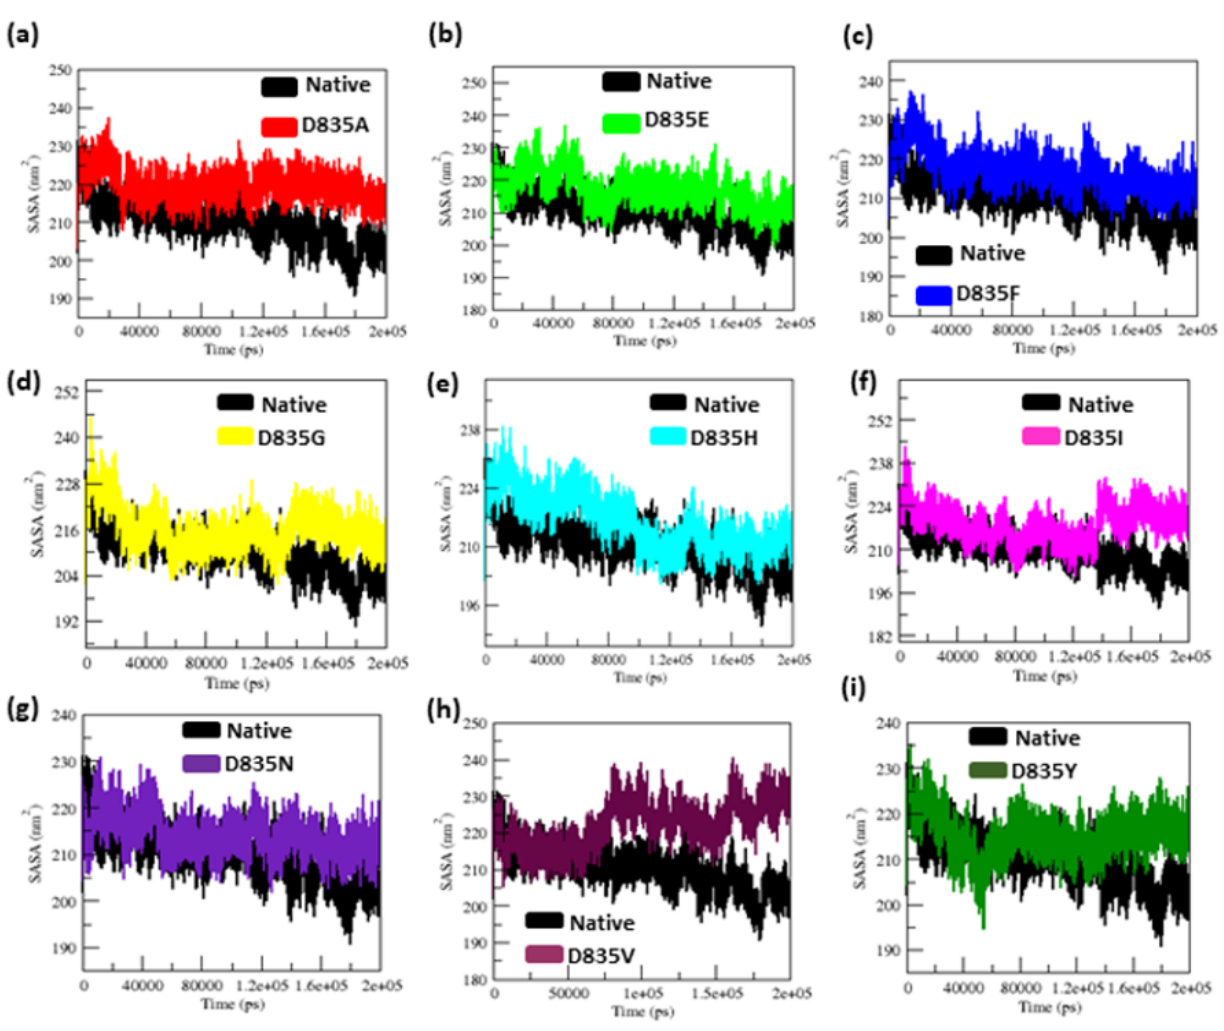
Figure 4. The solvent-accessible surface area (SASA) analysis for native and mutant FLT3 protein structures for the time frame of 200 ns. ( a ) Native vs. D835A; ( b ) Native vs. D835E; ( c ) Native vs. D835F; ( d ) Native vs. D835G; ( e ) Native vs. D835H; ( f ) Native vs. D835I; ( g ) Native vs. D835N; ( h ) Native vs. D835V; ( i ) Native vs.